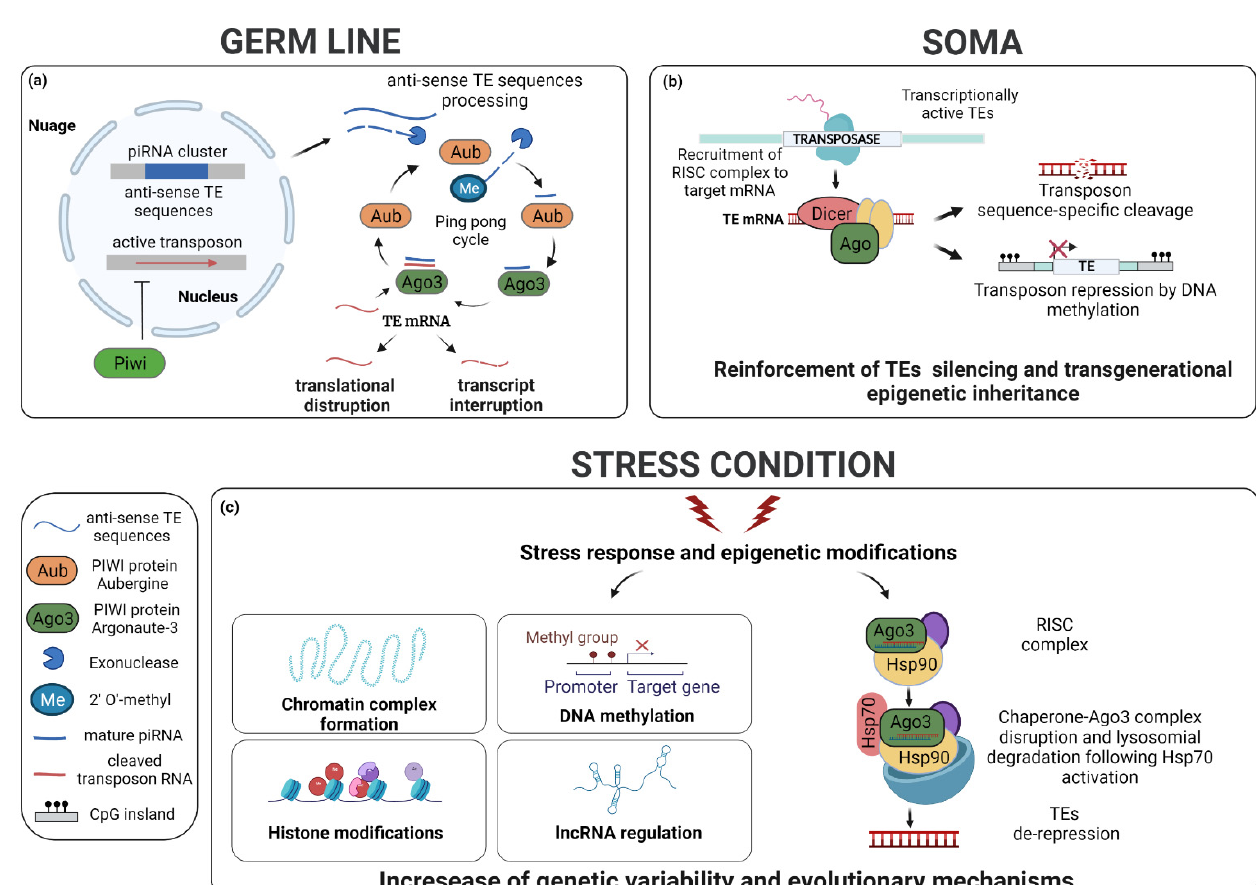
Figure 3. Regulation of TEs in germline and soma under standard and stress conditions. ( a ) Stepwise model of transcriptional silencing guided by Piwi-interacting RNAs (piRNAs). In the germline of Drosophila the silencing of TEs is guided by specific, small RNAs organized in piRNA clusters enriched in TE sequences. At the core of the pathway is the piRNA-induced silencing complex (pi-RISC) that consists of a single-stranded piRNA bound to a Piwi family protein. Piwi (light green) can guide the transcriptional silencing of TEs through direct assembly of the complex at heterochromatin target sites. Drosophila harbors three Piwi-like proteins: Piwi, Aubergine (Aub, orange), and Argonaute 3 (Ago3, dark green), which, guided by piRNAs, silence TEs post-transcriptionally (in addition to transcriptional silencing referred to above) through homology-dependent cleavage. Anti-sense TE sequences are exported from the nucleus and processed into smaller fragments by Aub before being loaded into Ago3. The resulting piRNA–Ago3 complexes cleave newly antisense piRNA precursors from clusters loaded into Aub to produce anti-sense piRNAs, resulting in a “ping-pong” amplification cycle. Additionally, Aub–piRNA complexes can bind TE transcripts and repress their translation directly. ( b ) In the soma the repression of TEs is mediated predominantly by the small interfering RNA (siRNA) pathway. siRNA precursors form short hairpin structures before being processed and incorporated into the RNA-induced silencing complex (RISC). Once a siRNA binds to its target TE mRNA, it induces the cleavage of such an mRNA by RISC. Other silenc- ing mechanisms involve chromatin remodeling. Several inhibitory marks, such as DNA methylation and histone methylation and deacetylation play an important role in repressing the mobilization of TEs. These epigenetic modifications may be passed on by dividing cells from one generation to the next. ( c ) When individuals are exposed to drastic environmental changes, they may experience stress-induced (re)activation of TEs. Epigenetic mechanisms like DNA methylation, histone modi- fications, expression of non-coding RNAs (ncRNAs) seem particularly relevant for this phenome- non. Additionally, environmental stress, such as heat shock, can induce de-repression of TEs by inducing the disruption of RISC through the action of the inducible Hsp70 chaperone, which tar- gets the complex to the lysosome. The generalized reactivation of TEs can generate genome insta- bility leading to higher risk of disease when occurring in somatic cells and to infertility when arising